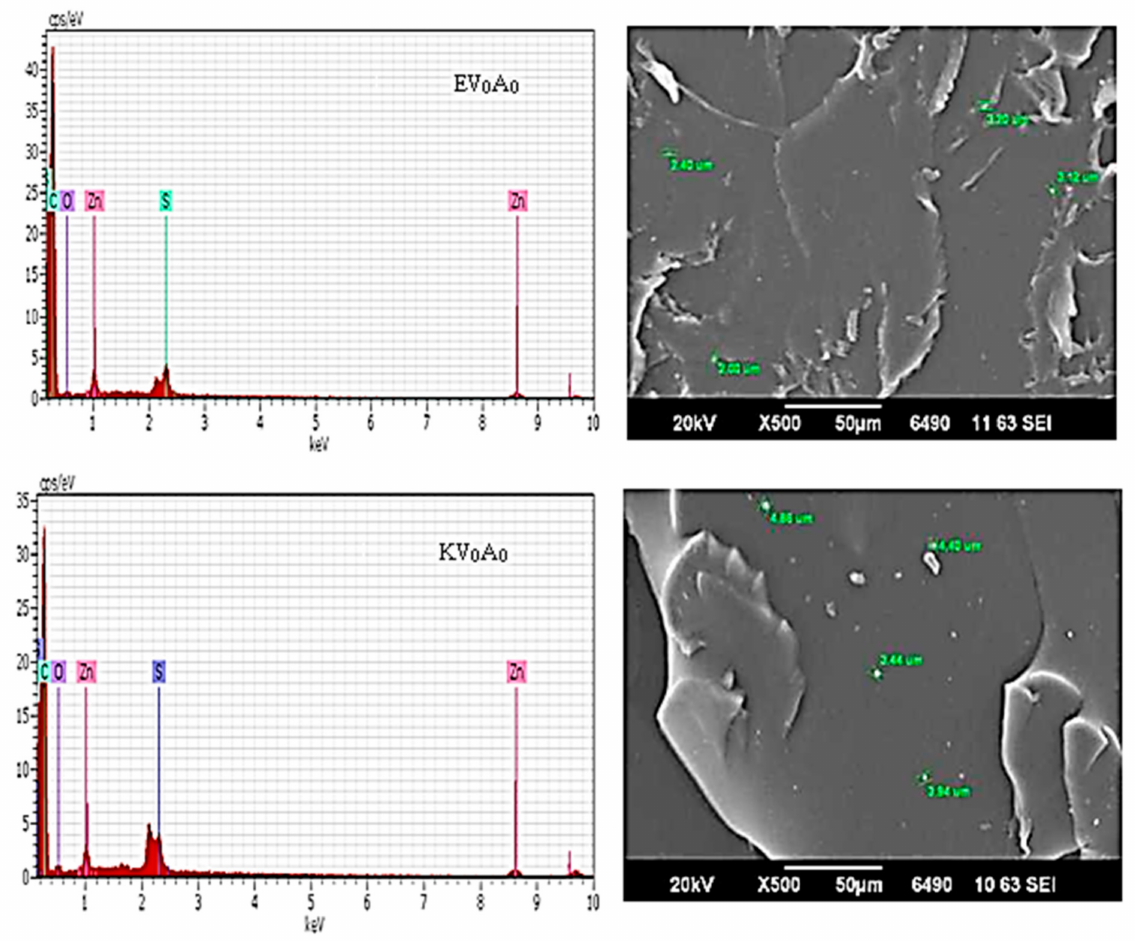
Figure 5. EDS spectra and SEM images of phase-3 composites without